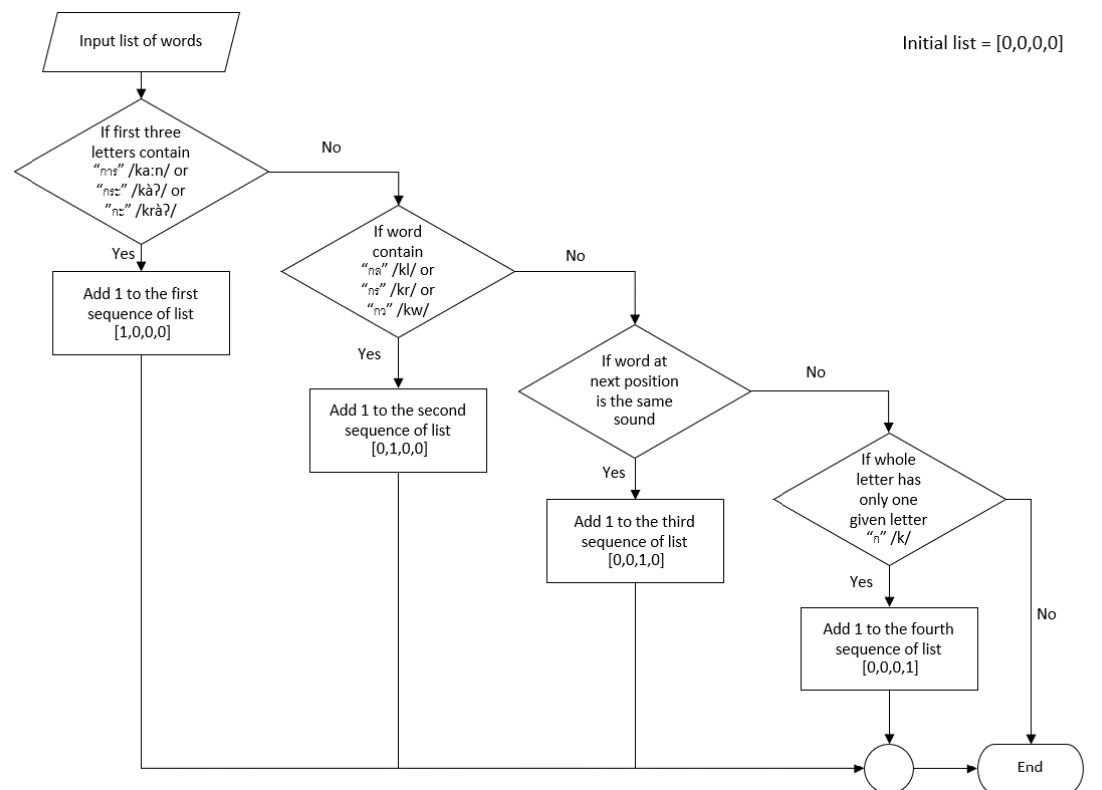
Figure A1. Flowchart of the clustering algorithm. The algorithm will iterate over all words, checking each cluster condition. The clustering score is calculated by the number of clusters that contain words. The maximum clustering score is 4. For example, if the result is (4,5,0,2), the clustering score is 3.